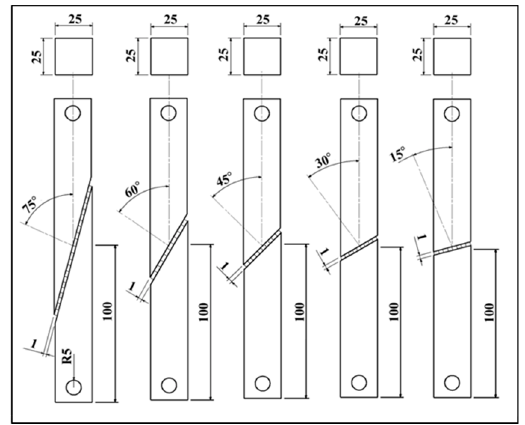
Figure 3. Schematic diagram of 15 ◦ , 30 ◦ , 45 ◦ , 60 ◦ and 75 ◦ scarf joints